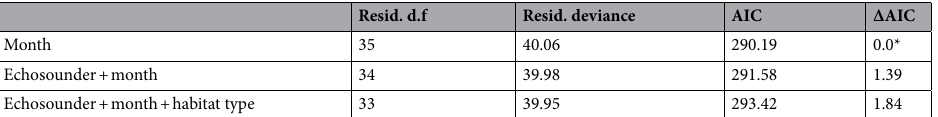
Table 2. Stepwise AIC selection process to assess the relationship between echosounder status and number of acoustic detections of usual click trains. An asterisk indicates the best fit model. The starting model (full model) was count ~ echosounder + month + habitat type, offset by the log of the trackline distance to account for differences in effort.